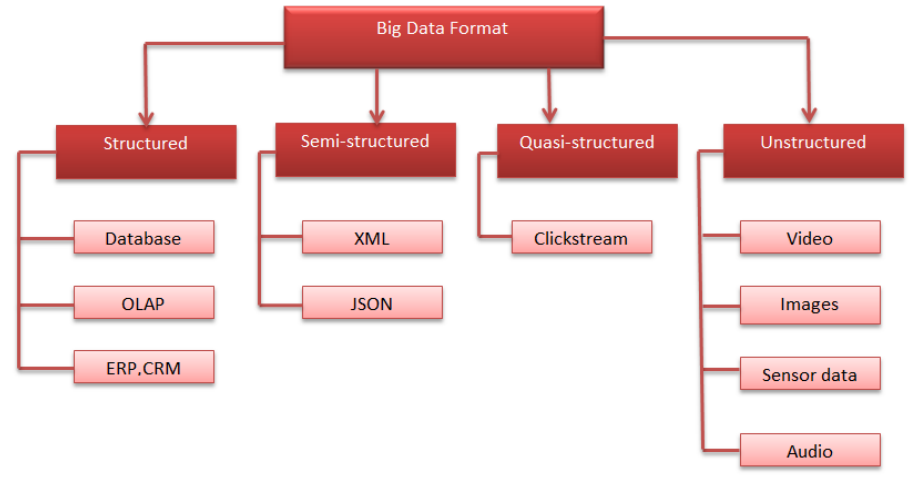
Figure 1. Big data Figure 1. Big data formats.